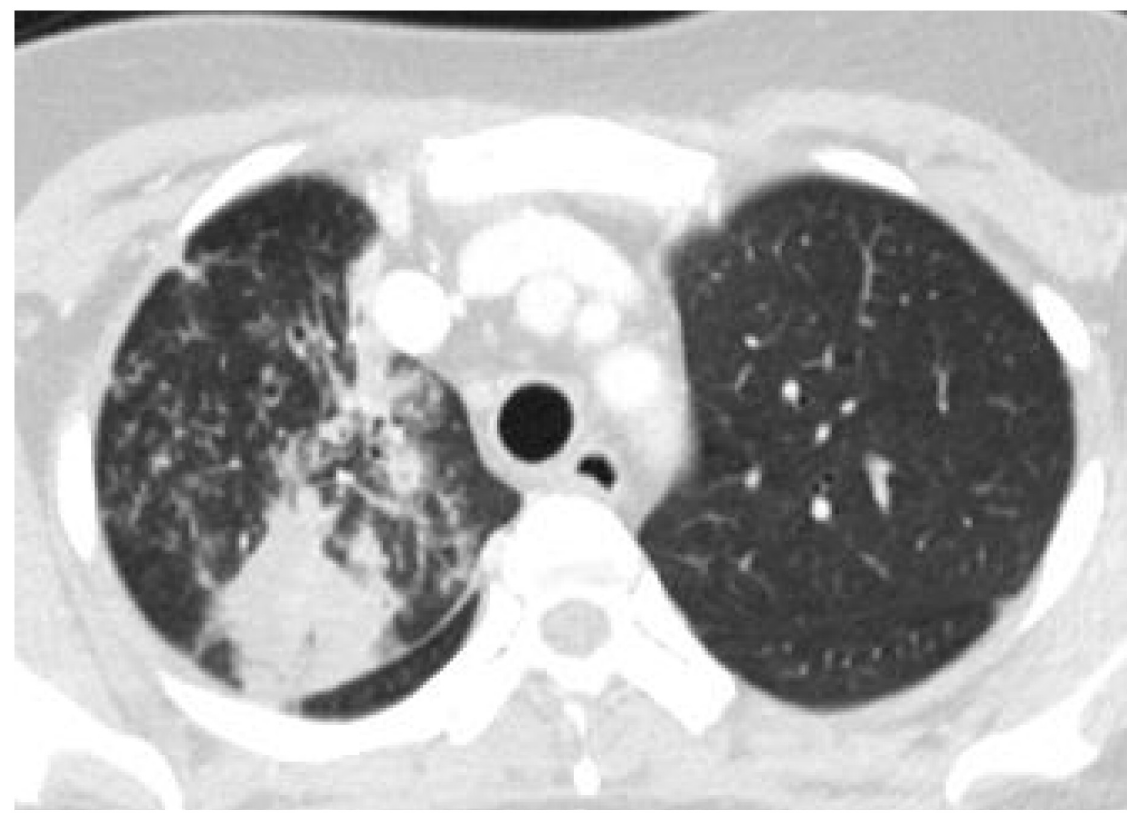
Fig 2. A 37-year-old woman with pulmonary TB with positive sputum MTB/RIF. Sputum acid-fast bacilli was negative, but sputum Xpert MTB/RIF was positive. Chest CT shows consolidation with multiple centrilobular nodules in the right upper lobe. Rapid TB medication was initiated and sputum culture also showed positive